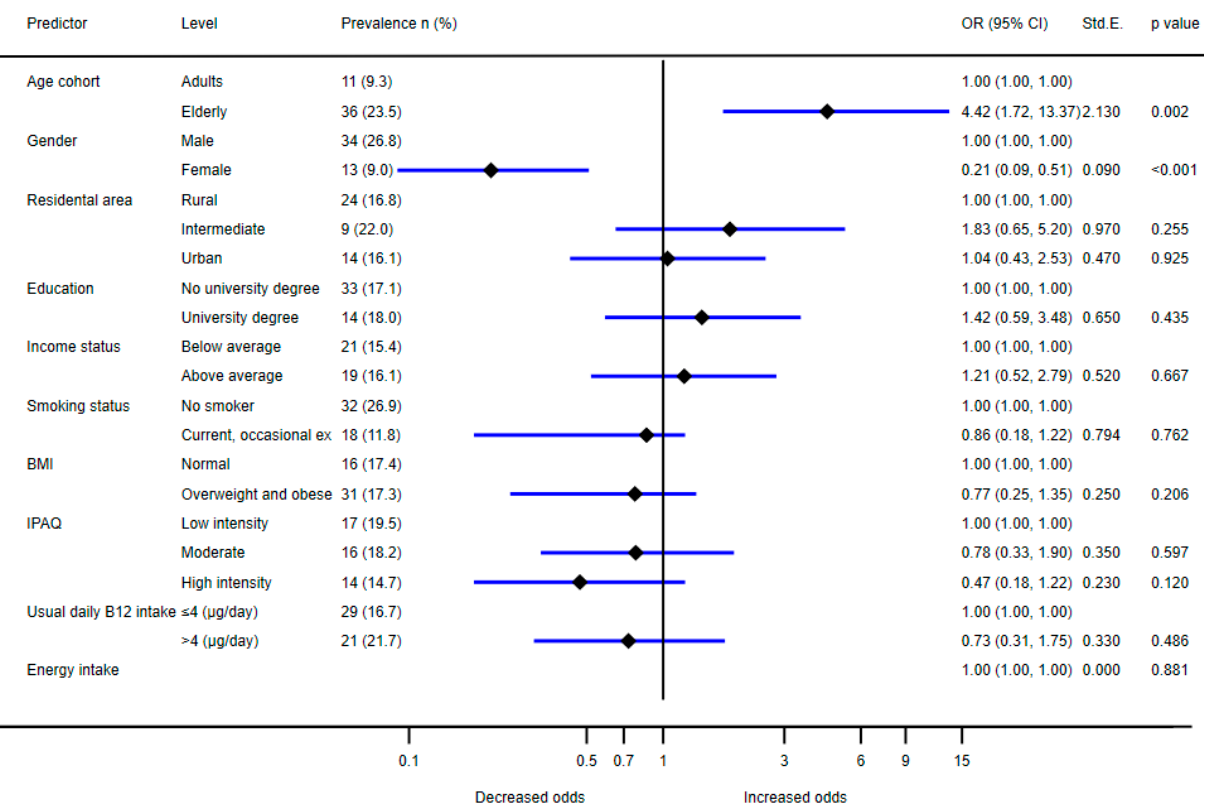
Figure 5. Analysis of differences in prevalence of vitamin B12 deficiency (serum vitamin B12 con- centration < 221 pmol/L and homocysteine > 15 µmol/L) between males and females in different age cohorts.